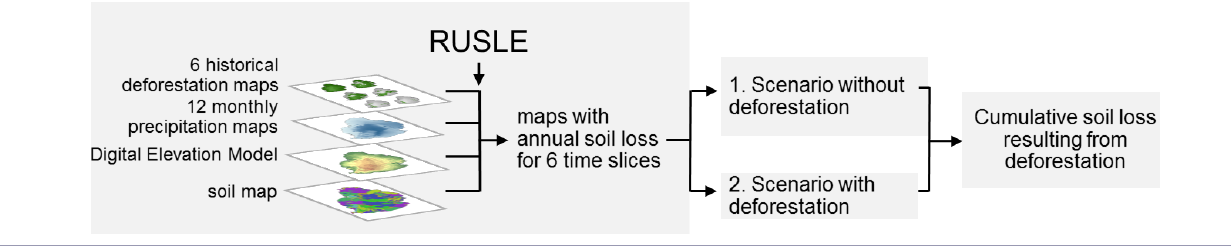
Table 1. Metadata and sources used to develop input maps